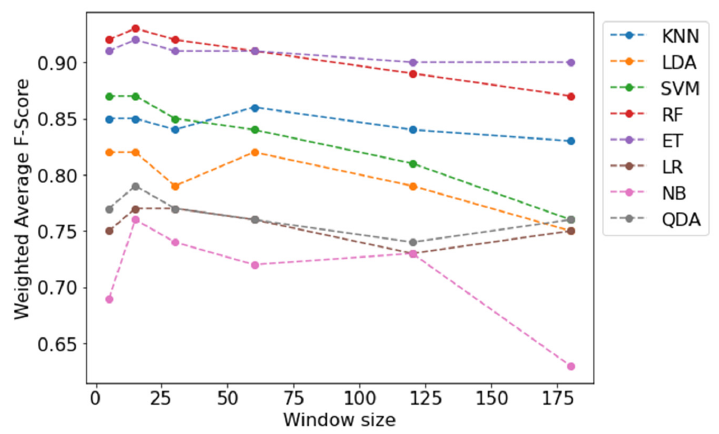
Figure 2. F-scores for each algorithm across all window lengths.